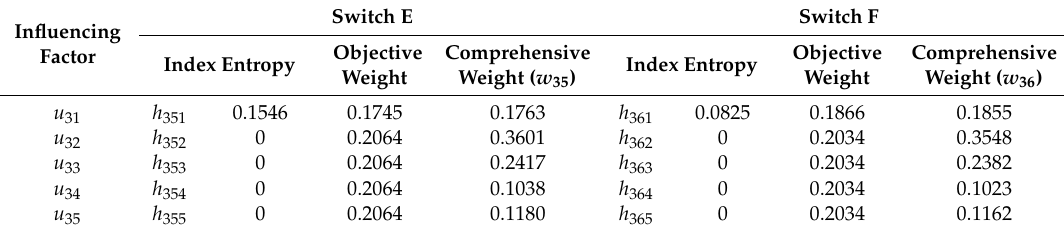
Table 20. The objective and comprehensive weights of the influencing factors of Switch E and Switch F.